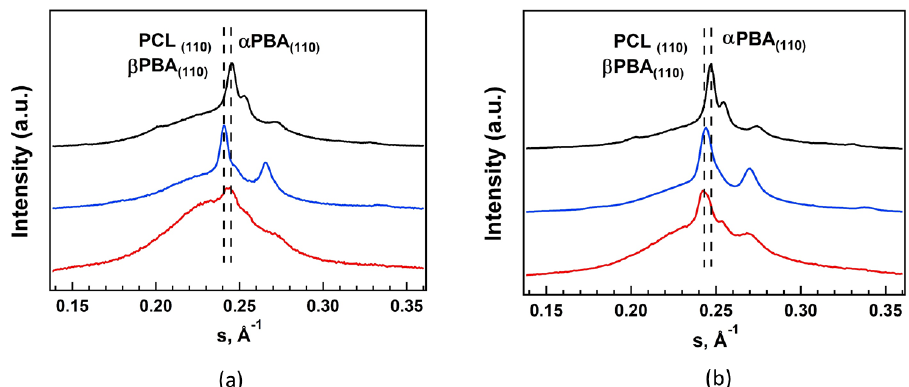
Figure 4. Diffractograms of TPU-381(PBA) (black curves), TPU-382(PCL) (blue curves) and TPU- 383(PBA/PCL) (red curves) after 2 weeks ( a ) and 36 months ( b ) of storage.